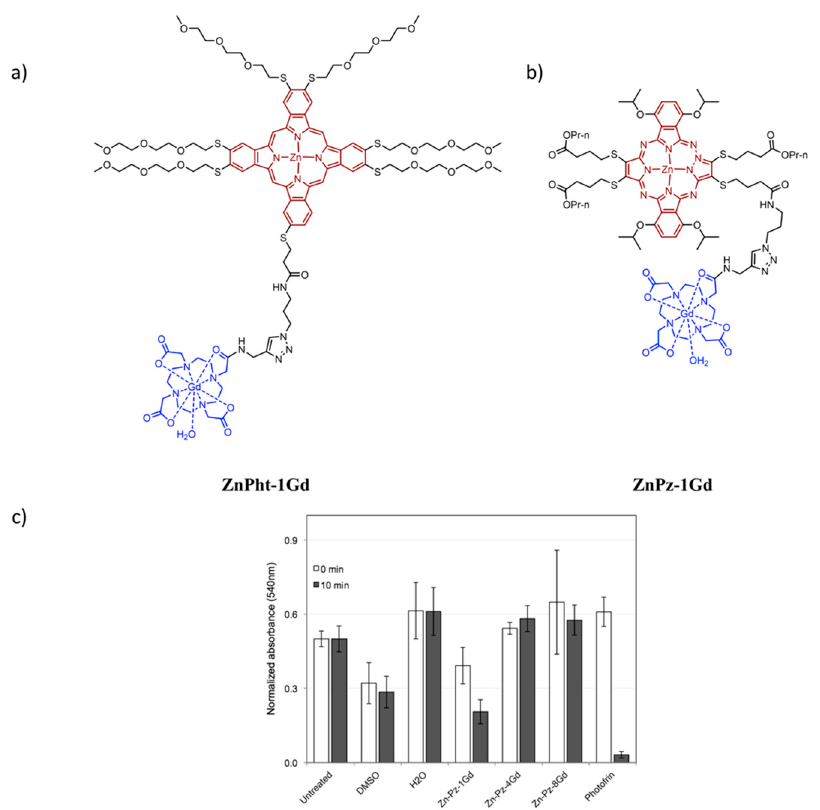
Figure 2. Chemical structure of ( a ) ZnPht-1Gd [44] and ( b ) ZnPz-1Gd [45]; ( c ) phototoxic effect in WI-38 VA13 cells incubated with Zn-Pz- n Gd ( n = 1, 4, 8; 50 µ M, 24 h) and irradiated by white light for 0 or 10 min. The same protocol was realized with Photofrin as a positive control. Adapted with permission from [45]. Copyright 2010 American Chemical Society.